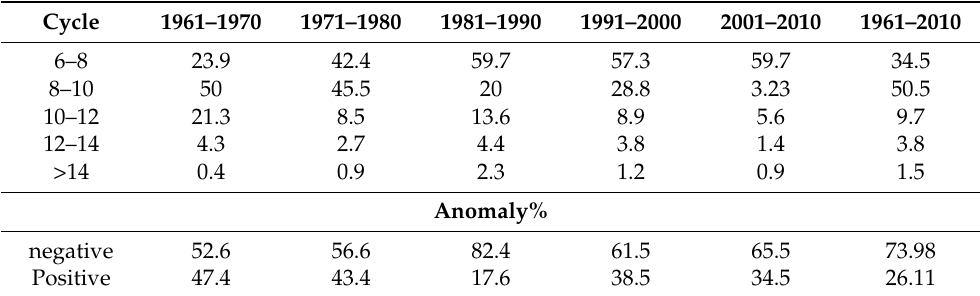
Table 2. Percentage of the area covered by the mean of extreme precipitation thresholds during different